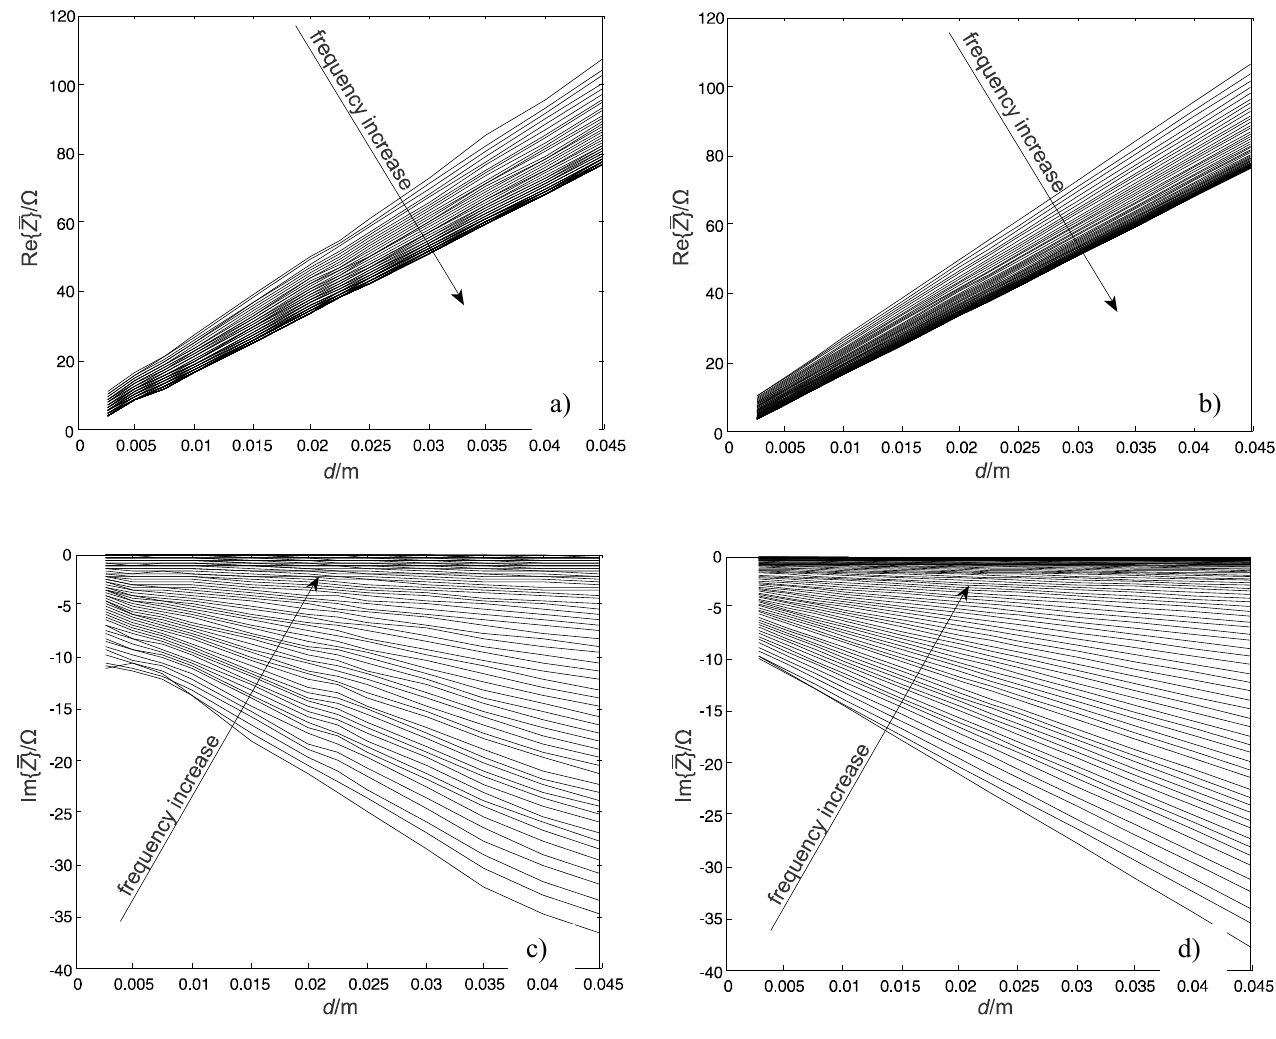
Fig. 4: Measured and fitted real (a and b) and imaginary (c and d) part as a function of the distance between the electrodes. For each measured frequency one fitted curve as a linear function of the distance between the electrodes is